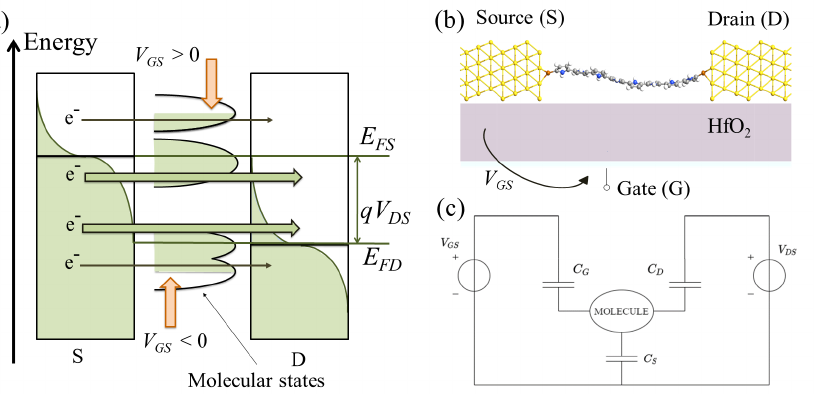
Figure 3. ( a ) Pictorial representation of the gating effect on a generic single-molecule FET; ( b ) rep- resentation of the structure of the proposed Au-8PyDT FET; ( c ) capacitive equivalent model of a generic